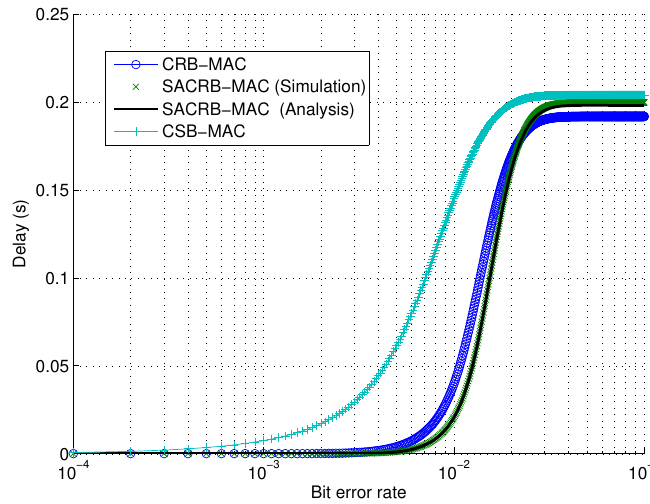
Figure 4. Single hop delay performance against bit error rate.